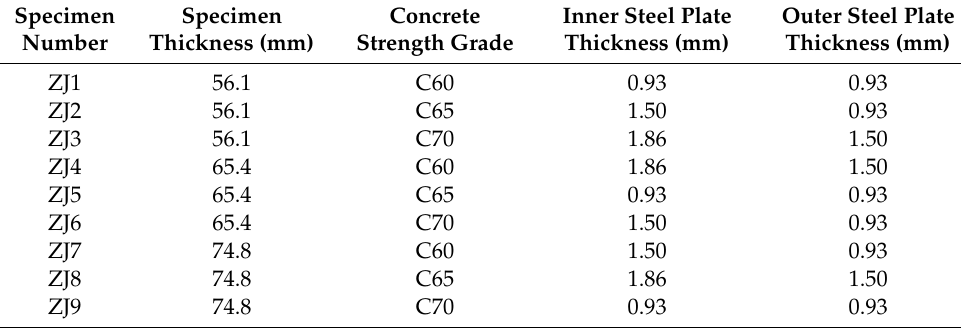
Table 1. Parameters of the shaft lining model